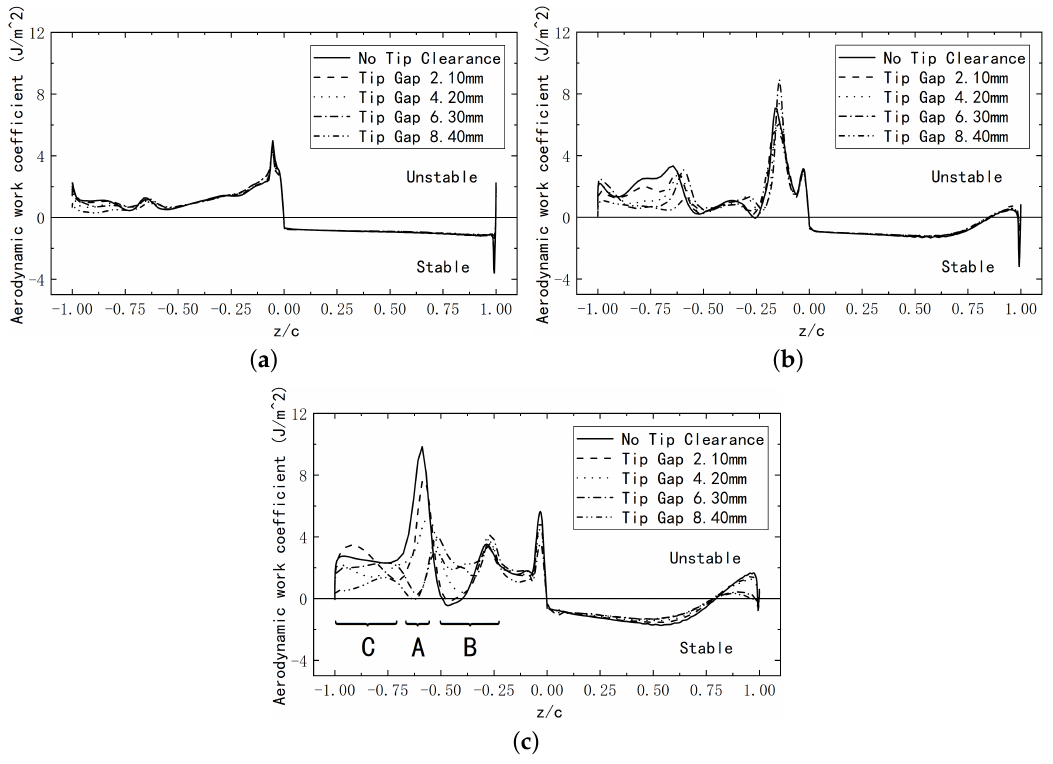
Figure 10. Distribution of the wall work coefficient at ( a ) 80%, ( b ) 90%, and ( c ) 98% span; the abscissa is the ratio of chord coordinates to the length of chord, and − 1–0 indicate the trailing edge to the the leading edge on the suction surface, while 0–1 indicate the leading edge to the trailing edge on the pressure surface.